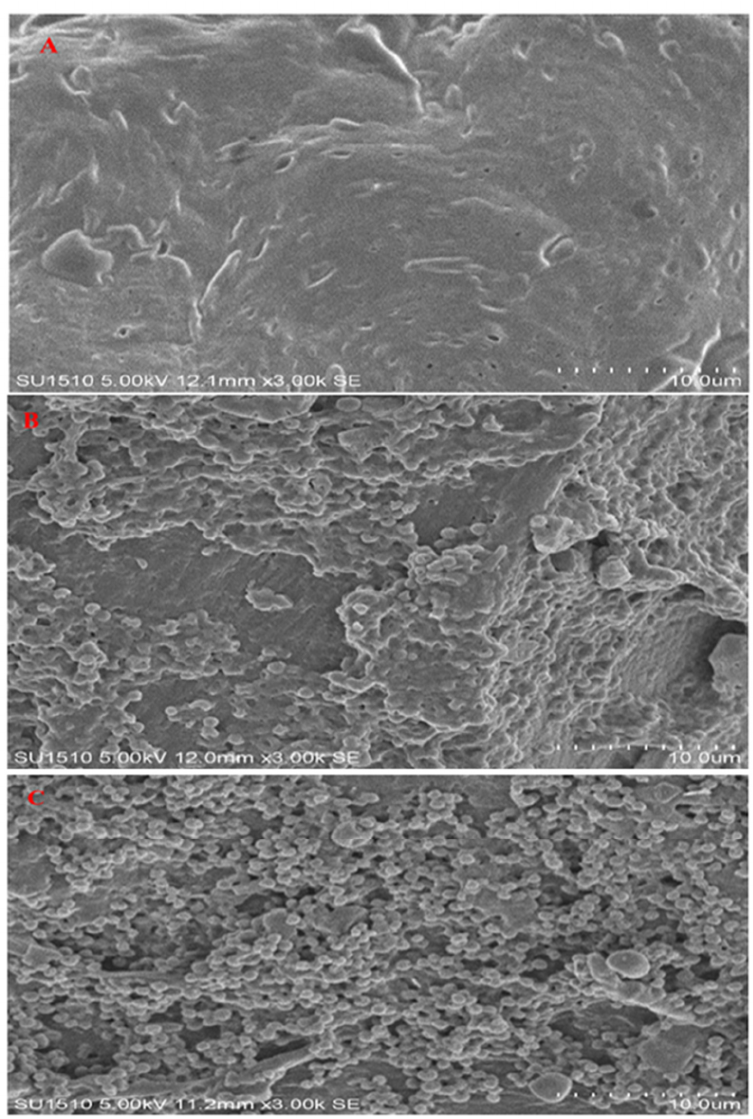
Figure 2. Scanning electron microscopy of bighead carp H. nobilis fillets. ( A ) Raw; ( B ) oven drying; ( C ) microwave drying.